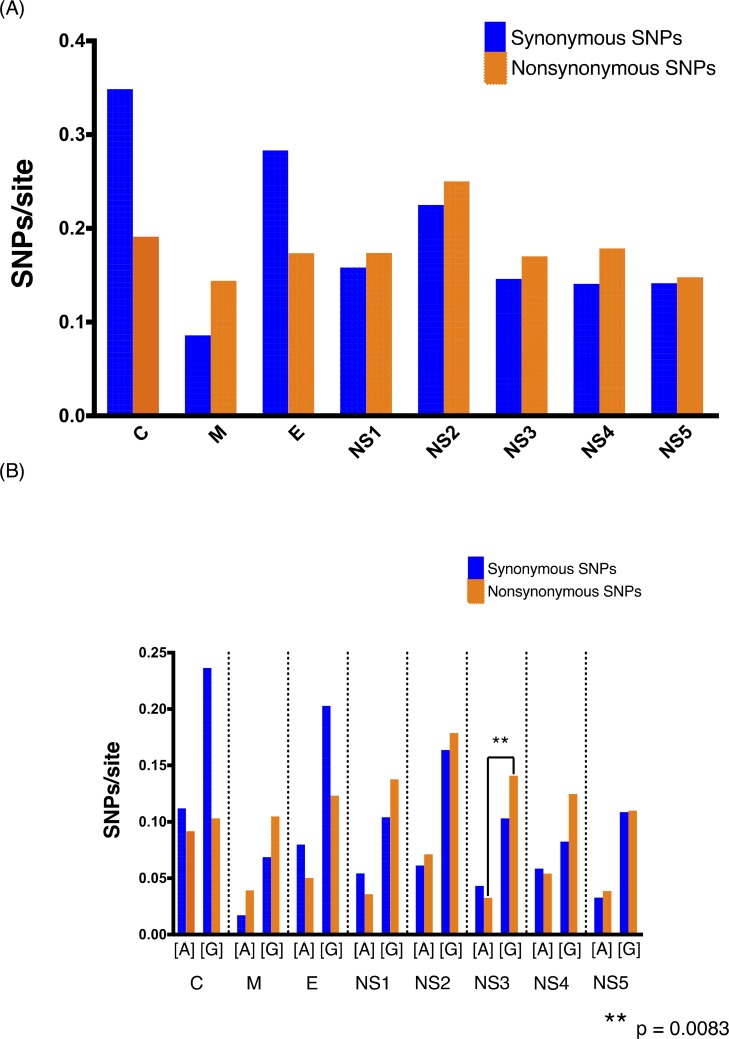
Significant increase in NS3 nonsynonymous SNPs/site associated with strain turnover.The repertoire of SNPs present above 1% within-hosts was visualized as a pooling of all samples (A) as well as a side by side comparison of clade A vs. G (B). SNP count was normalized to the number of synonymous and nonsynonymous sites per gene. Genes are separated by a dotted line across the plot and identified by initials below the axis. There were no significant differences between genes when all samples were pooled. A significant increase in nonsynonymous SNPs/site is observed across NS3.